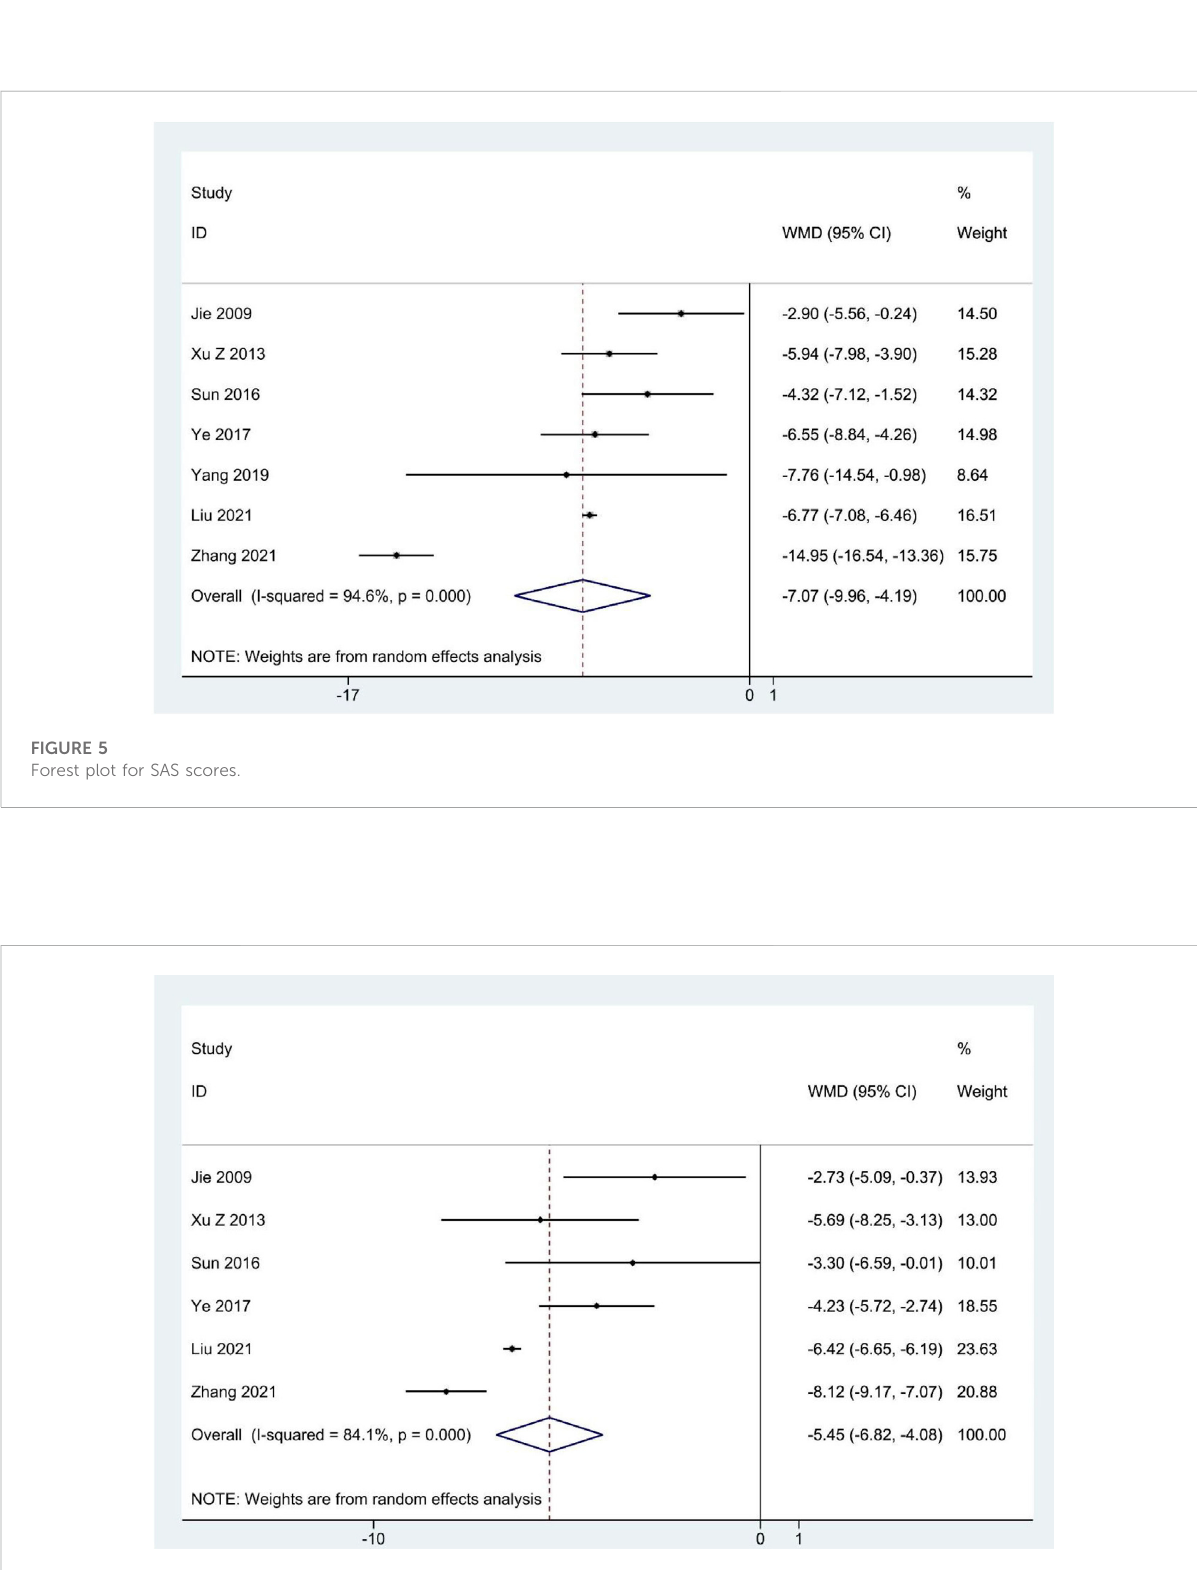
FIGURE 6 Forest plot for SDS